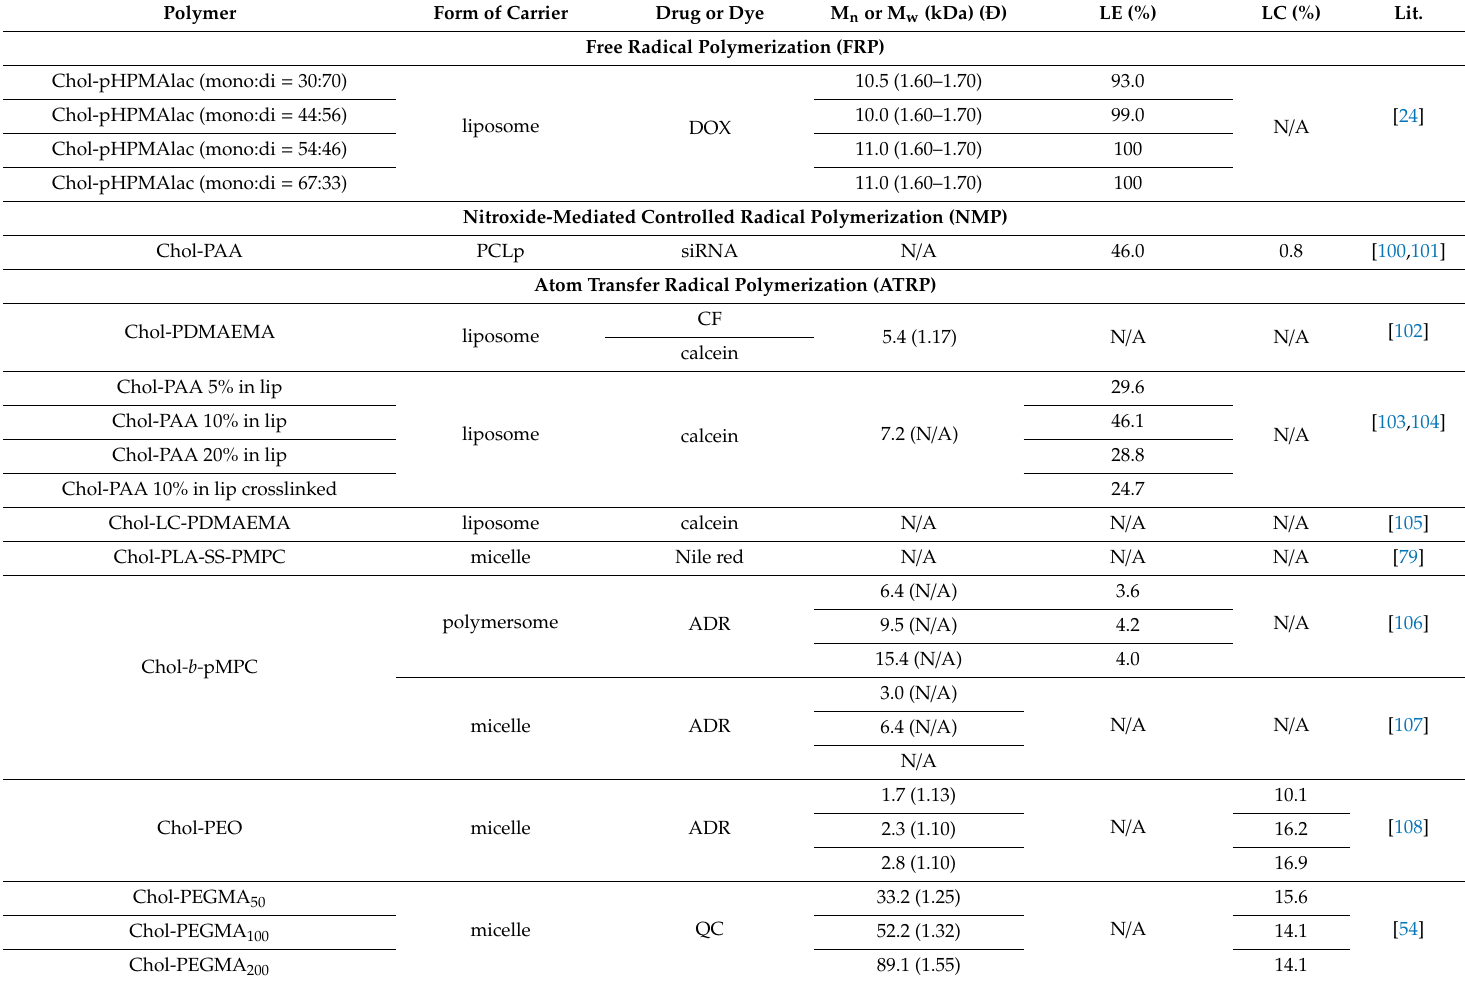
Table 1. Cholesterol end-capped polymers reported as drug delivery